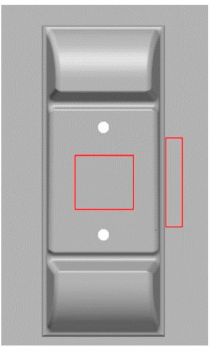
Figure 13. Dimensions of the area measured to extract the slope.